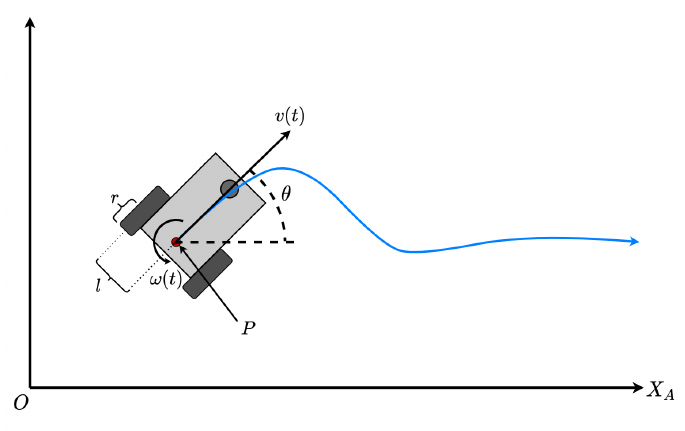
Figure 2. Ground vehicle